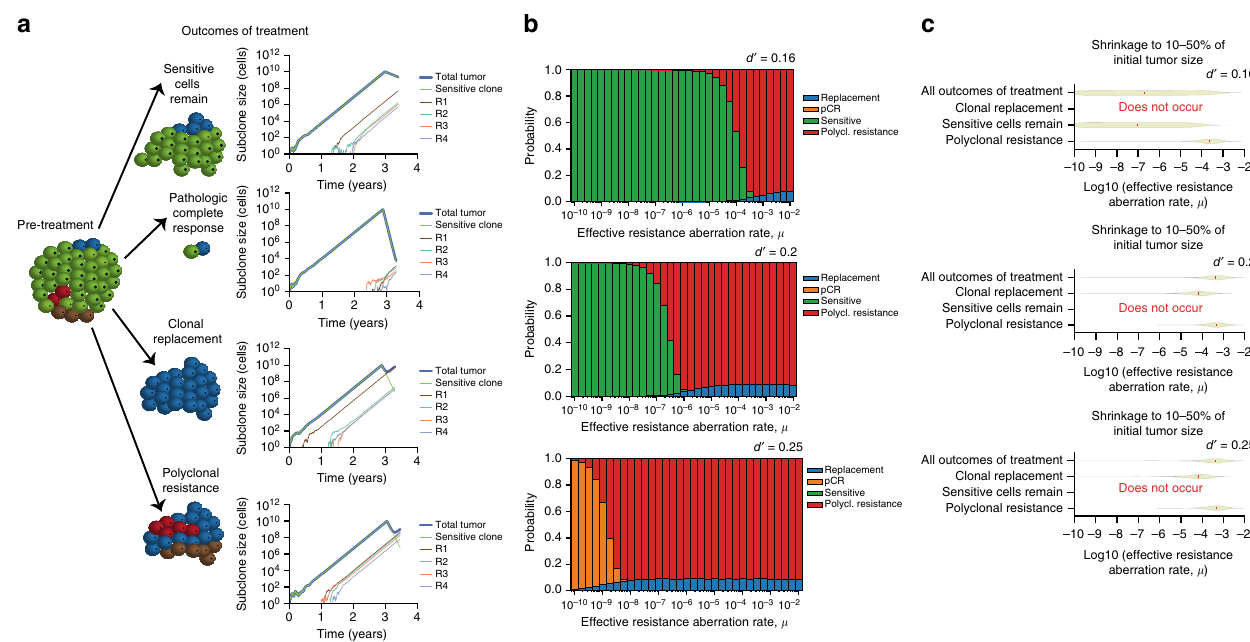
Fig. 5 Evolutionary paths to different treatment outcomes. a Schematics of and example paths to the four de fi ned treatment outcomes. In each simulation, the tumor grew to 10 billion cells and then was treated for 150 days. The size of the tumor and the fi rst four resistant clones (R1 – R4) are shown throughout primary tumor growth and treatment. b Stacked bar plots showing the proportion of simulated tumors with each of the four de fi ned treatment outcomes for three plausible death rates of sensitive cells during treatment ( d ’ = 0.16, 0.2, or 0.25) and varying effective resistance aberration rates ( μ , varied from 10 − 10 to 10 − 2 across the x -axis of each plot). The effective resistance aberration rate is the product of the rate of accumulation of genomic aberrations per site per cell division and the number of such aberrations that can confer resistance. Clonal replacement (blue) occurs at a rate of ~10% across many sets of parameters. c Inference of effective resistance aberration rates ( μ ) for tumors that shrink to 10 – 50% of initial tumor size with treatment (matching the degree of tumor shrinkage observed in our cohort). We show inferred μ for the three plausible sensitive cell death rates ( d ’ = 0.16, 0.2, or 0.25) and for possible treatment outcomes (clonal replacement, polyclonal resistance, and sensitive residual disease). For such large residual tumors to occur, either the sensitive cell death rate ( d ’ ) must be low, in which case clonal replacement cannot occur, or the effective resistance aberration rate ( μ ) must be high. Source data for panels b and c are provided as a Source Data fi